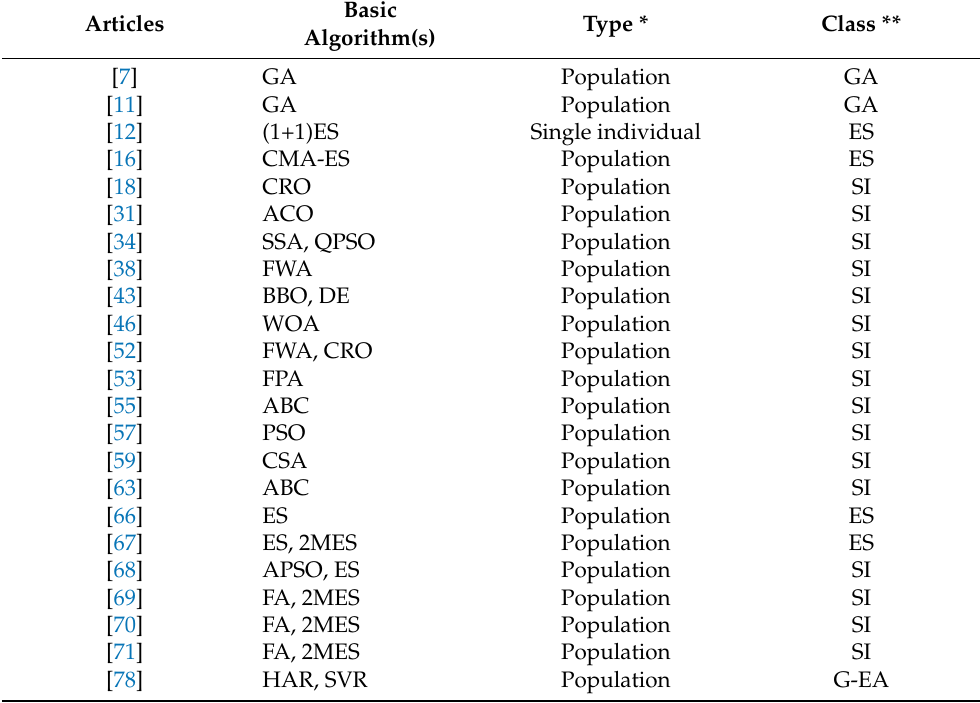
Table 2. Basic algorithms used in reviewed articles.